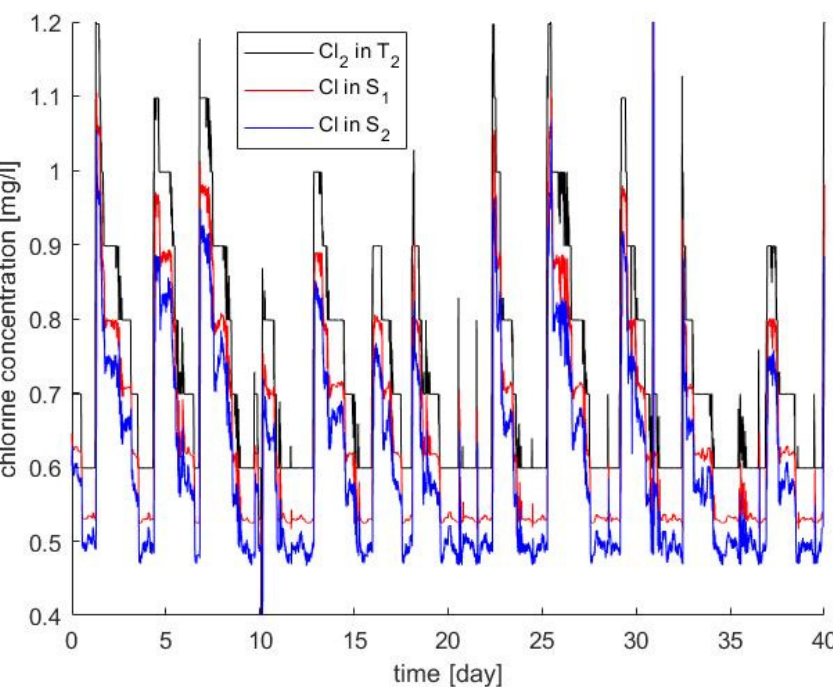
Figure 7. Measured chlorine concentration at the source (T 2 ) and prediction at the two sampling points (S 1 and S 2 ).